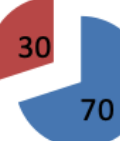
Figure 4: How capacity building has been